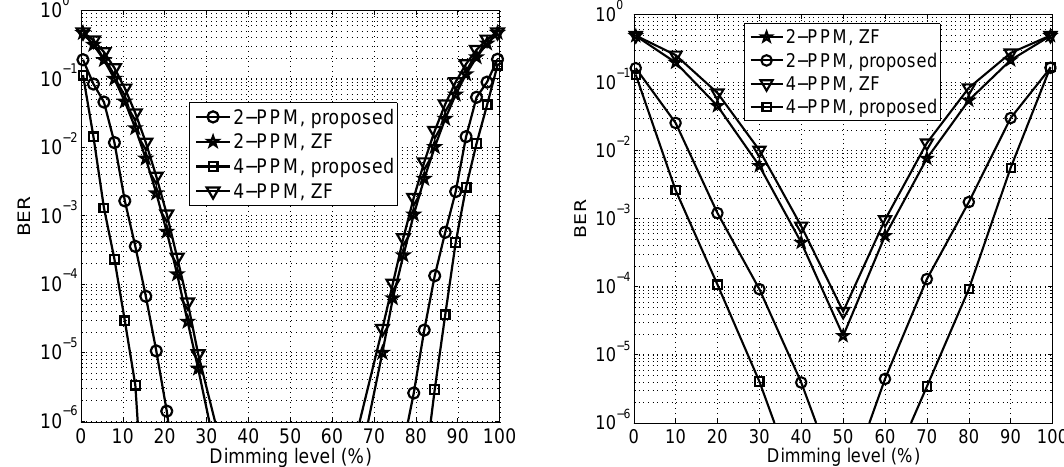
Figure 5. BER of the multiuser VLC system using PPM (left: Scenario 1, right: Scenario